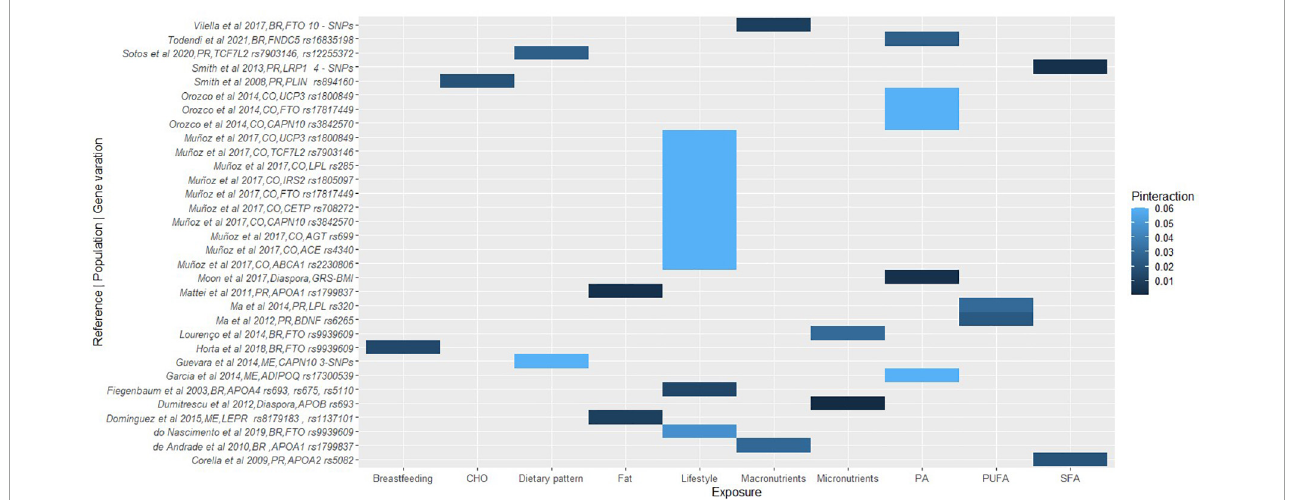
FIGURE3 A heat map showing the findings for gene-lifestyle interactions on obesity traits. Vilella et al. (80), 10-SNPs = FTO rs79149291, rs62048379, rs115530394, rs75066479, rs2003583, rs115662052, rs114019148, rs62034079, rs1123817, rs16952663; Smith et al. (146), 4-SNPs = LRP1 rs1799986, rs1799986,